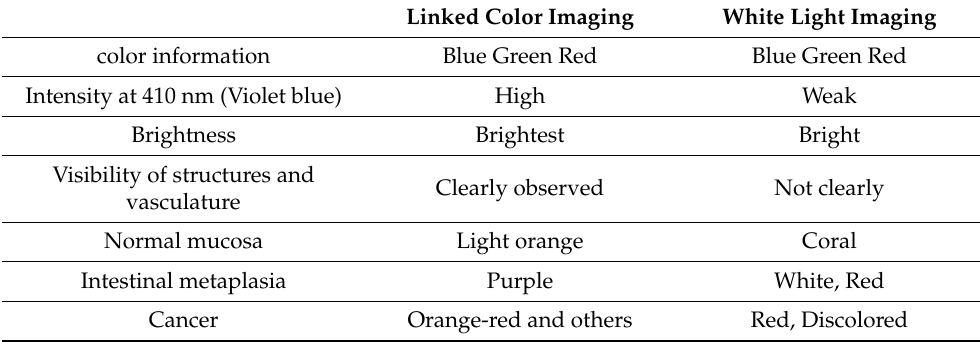
Table 1. Comparison of linked color imaging and white light imaging in the stomach (adapted from Ref.